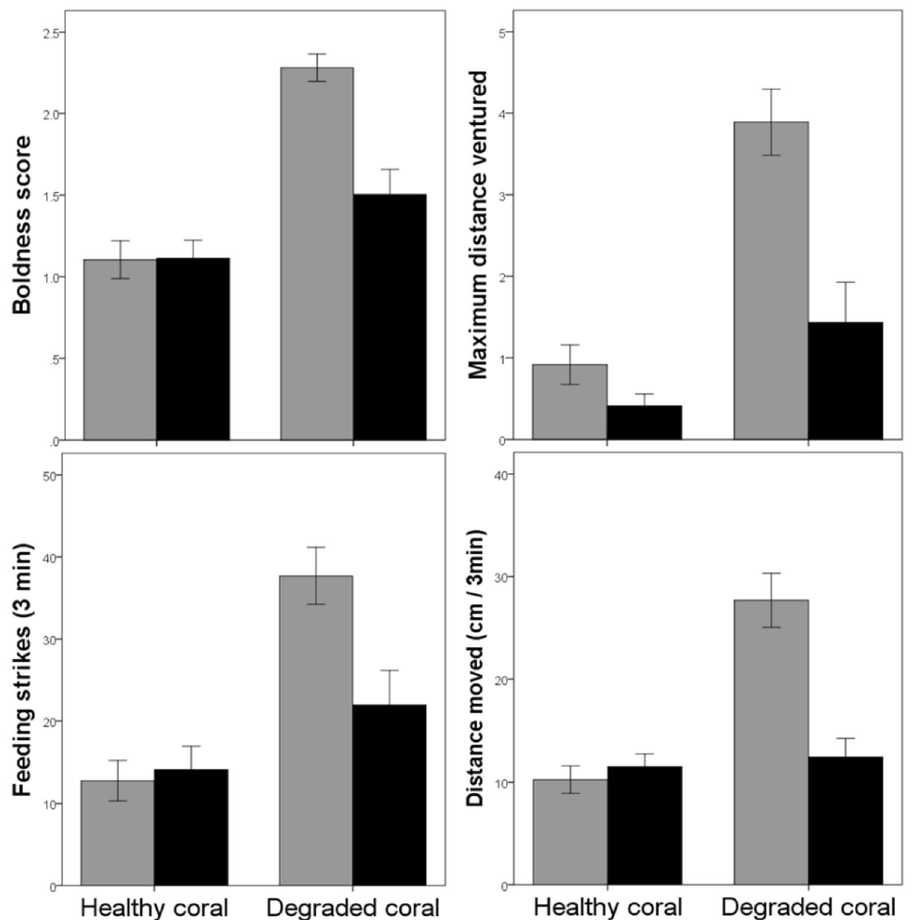
Figure 2. Mean (± SE) boldness score (top, left), maximum distance ventured (top, right), number of feeding strikes (bottom, left) and distance moved (bottom, right) for P. amboinensis in situ. Prior to deployment in the field, P. amboinensis were taught to recognize three common predators (lizardfish, wrasse and dottyback) using alarm cues from conspecifics ( P. amboinensis , grey bars) or alarm cues from a closely-related heterospecific ( P. chrysurus , black bars). The training took place in water containing cues from either healthy, live or dead, degraded Pocillopora damicornis